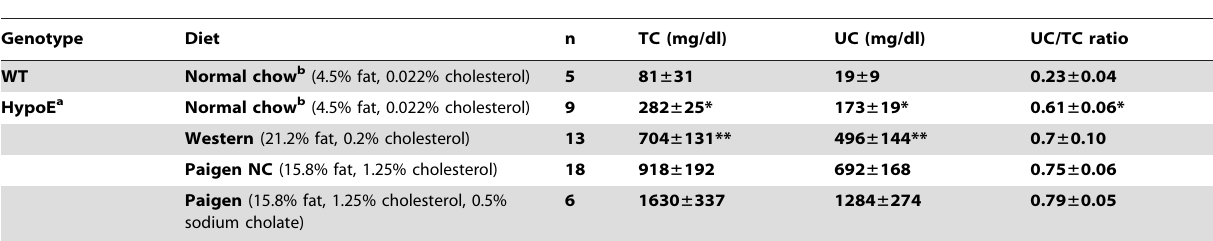
Table 1. Effects of atherogenic diets on plasma lipids.